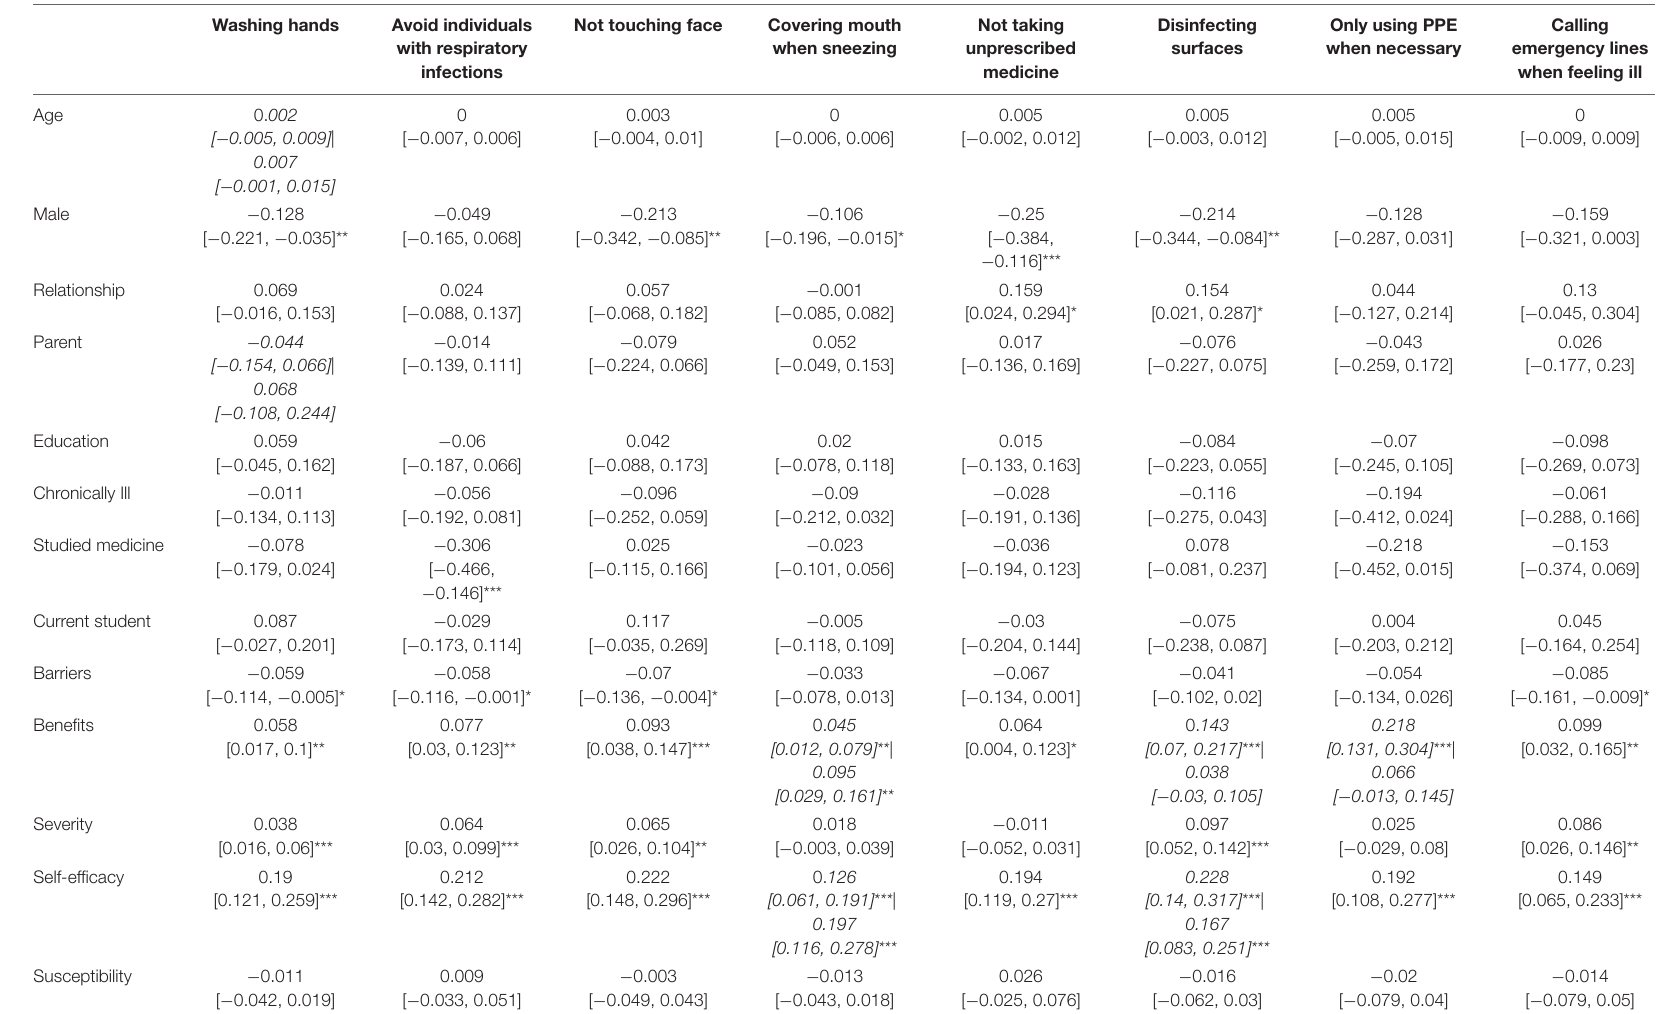
TABLE 5 | Model Results for the SEM path-model across countries.